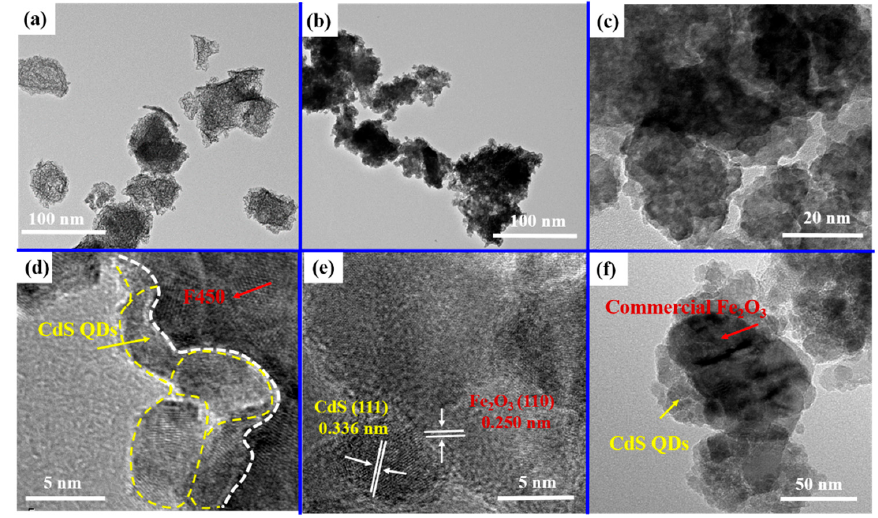
Figure 3. ( a ) TEM image of pure F450; ( b , c ) TEM image of 5-CdS / F450; ( d , e ) high-resolution TEM images of 5-CdS / F450; ( f ) TEM images of pure CdS.